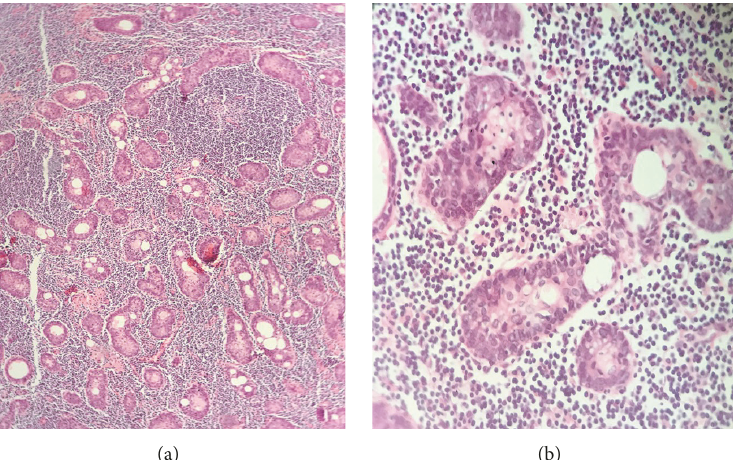
Figure 4: Sebaceous lymphadenoma micrograph ((a) × 10). The tumor is biphasic composed of epithelial nests and lymphoid background; ((b) × 40) solid nests with squamous and sebaceous